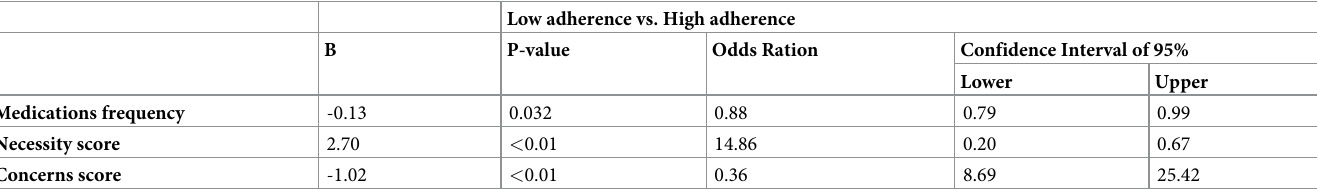
Table 5. Ordinal regression of adherence